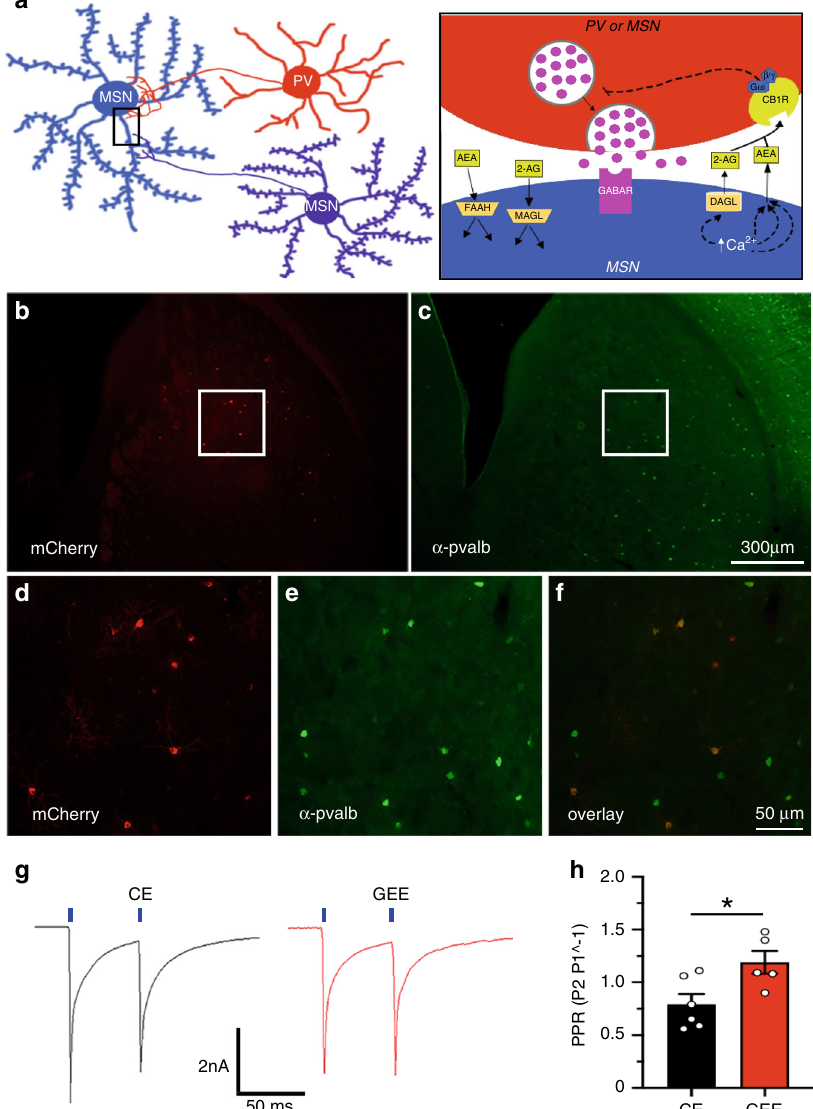
Fig. 5 GEE decreases the ef fi cacy of the parvalbumin-expressing interneuron to MSN synapse in the DLS. a Schematic diagram of the synaptic connectivity of PVs and MSNs (Left), and endocannabinoid siganling at the PV-MSN GABAergic synapse. b , c Example of a section obtained from a parvalbumin ( Pvalb )- cre transgenic mouse injected into the dorsal striatum with a Cre-sensitive viral vector ( AAV2-DIO-ChR2-mCherry ) following immunohistochemistry using an antibody raised against against pvalb and visualization of mCherry. d – f Increased magni fi cation of boxed regions in b and c shows that a majority of neurons that express mCherry also express pvalb. g Responses of MSNs recorded within DLS slices obtained from CE and GEE mice to two 5-ms pulses of 488 nm wavelength with an interstimulus interval of 50 ms. h Paired-pulse ratio of DLS-MSNs recorded from CE and GEE mice. Error bars equal ± SEM, * t -test = p <